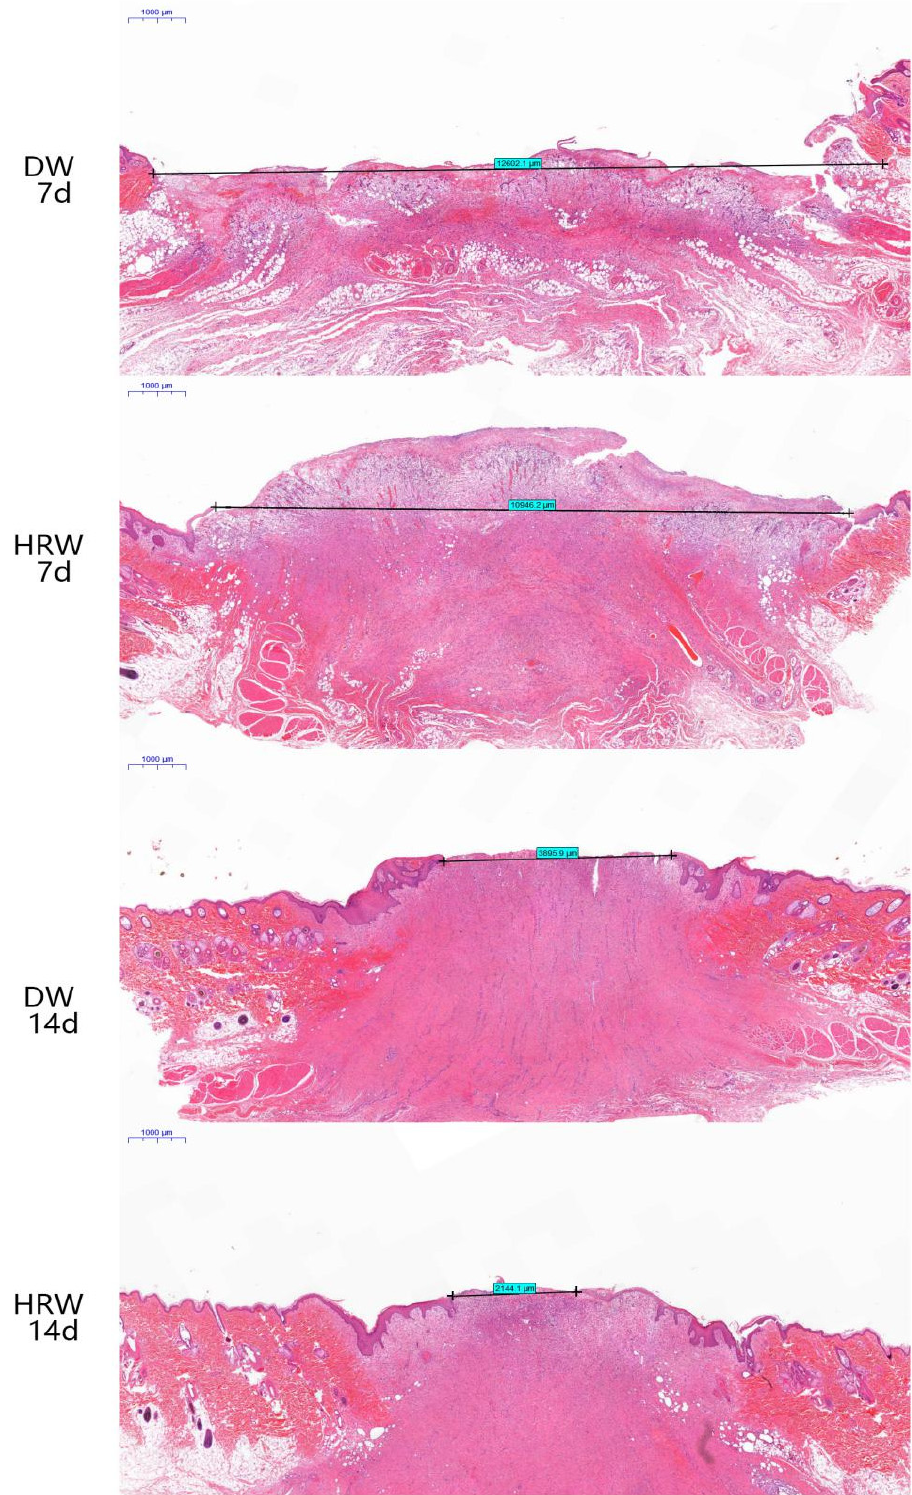
Figure 4. H&E staining was used to measure the length of wound of dogs in the HRW group on days 7 (10,946.2 μ m) and 14 (2144.1 μ m) and the DW group on days 7 (12,602.1 μ m) and 14 (3895.9 μ m).